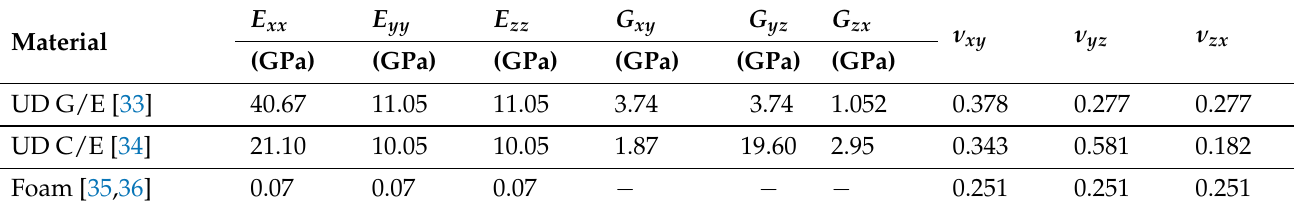
Figure 2. ( a ) 3-D beam geometry of the helicopter rotor blade consisting of unidirectional glass/epoxy (UD G/E), unidi- rectional ± 45 ◦ carbon/epoxy (UD C/E), and isotropic foam; ( b ) cross section near the root; ( c ) cross section at the tip of the rotor. Table 1. Elastic bulk properties of unidirectional glass/epoxy (UD G/E), unidirectional carbon/epoxy (UD C/E), and isotropic foam for helicopter composite blade